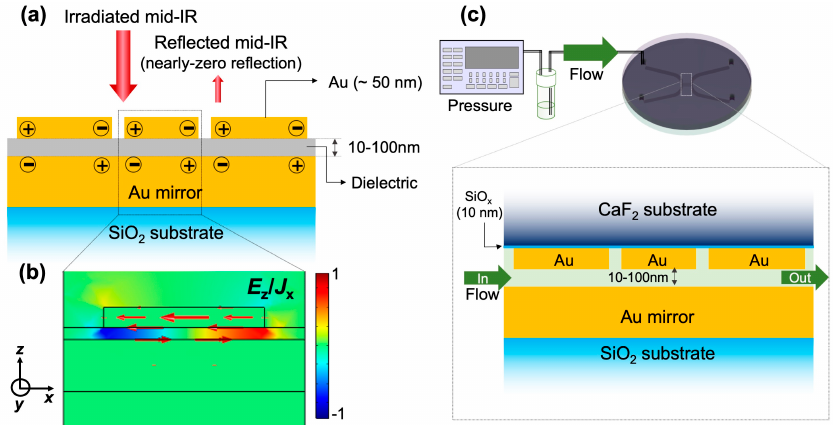
Figure 1. ( a ) Conceptual diagram of metal-insulator-metal (MIM) perfect absorber metamaterial structures for plasmon-enhanced infrared absorption spectroscopy, ( b ) profiles of electric field E z and current density J x indicated by red arrows elucidating the formation of the quadrupole resonance mode, and the trapping of near-field energy within the nanogap, and ( c ) conceptual diagram of nanofluidic device integrated with MIM perfect absorber structures.